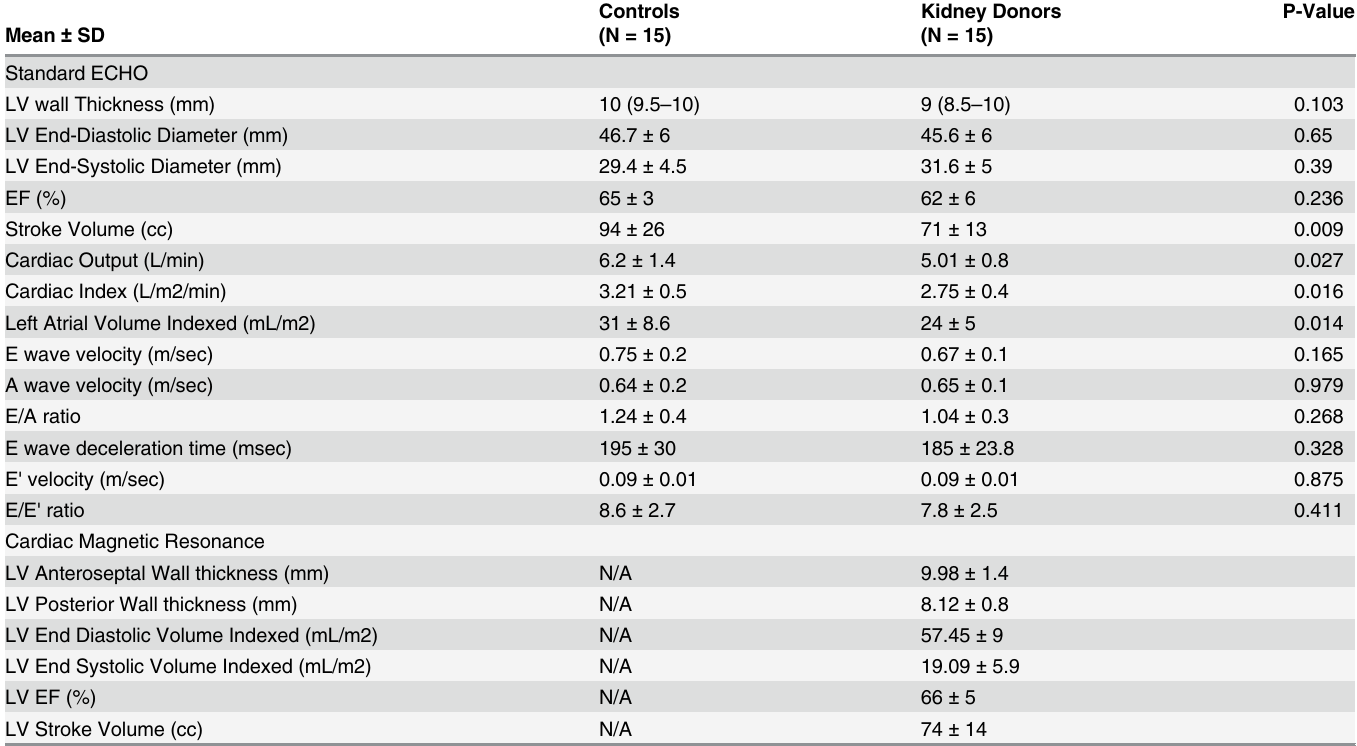
Table 2. Standard ECHO and Cardiac MRI. Two-dimensional and standard Doppler echocardiographic variables in living kidney donors and controls. Con- trast-Enhanced Cardiac Magnetic Resonance data obtained on living kidney donors are reported as